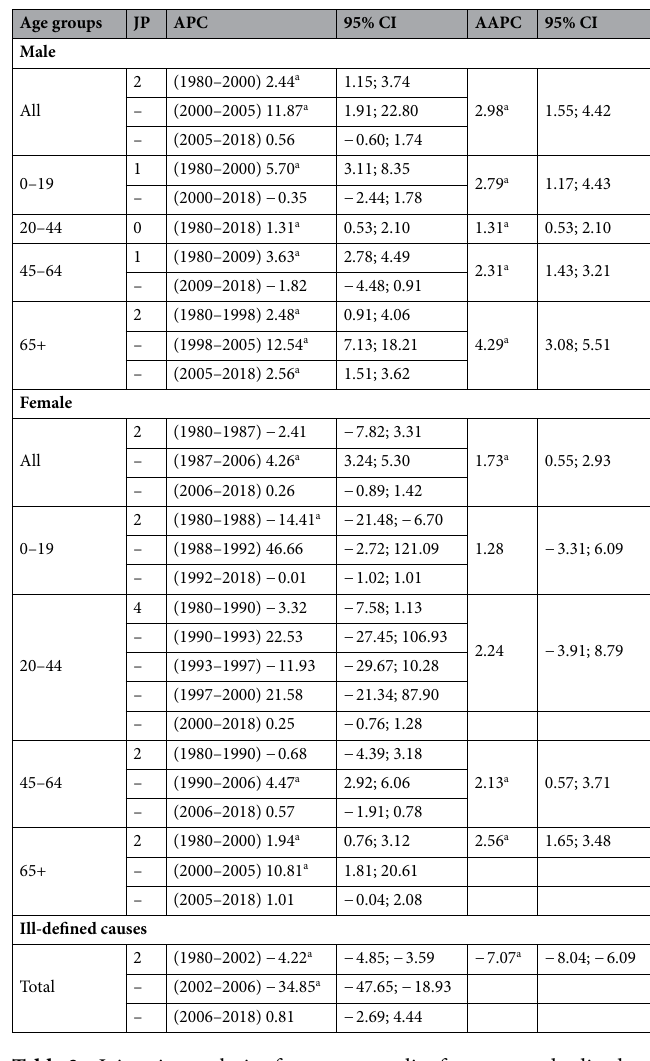
Table 2. Joinpoint analysis of cancer mortality for age-standardized rates for all ages and specific for age groups for both sexes. Sergipe, 1980–2018. JP number of join points, APC annual percent change, AAPC average annual percent change, CI Confidence interval. a APC/AAPC statistically